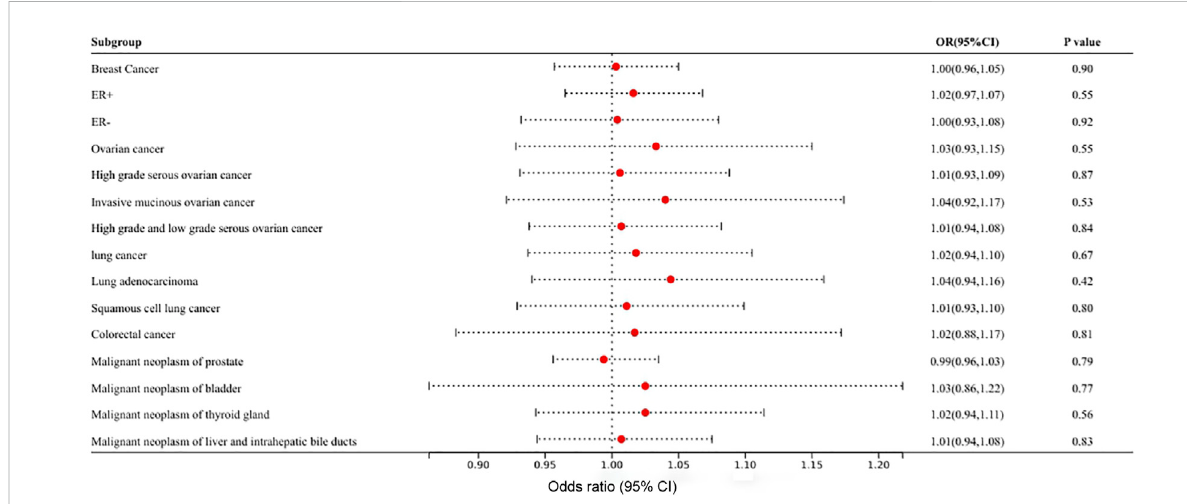
Mendelian randomization results of the association of different types of cancer on circulating VEGF.